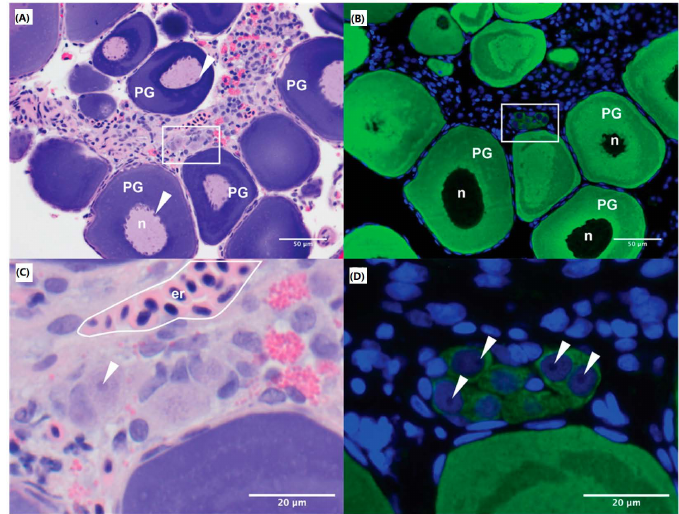
Figure 1. Histology of M. fluviatilis ovary. Ovarian tissue section stained with haemotoxylin and eosin ( A ) and anti-Vasa antibody (green fluorescence) and Hoechst nucleic counter stain (blue fluorescence) ( B ). A number of oocytes in the primary growth stage (PG) are present and a region of interest surrounded by a white box ( C , D ) shows a cluster of oogonia embedded within the germinal epithelium. Er: erythrocytes; n: nucleus; PG: primary growth stage oocyte; White arrow: nucleoli. Animals 2022 , 12 , x